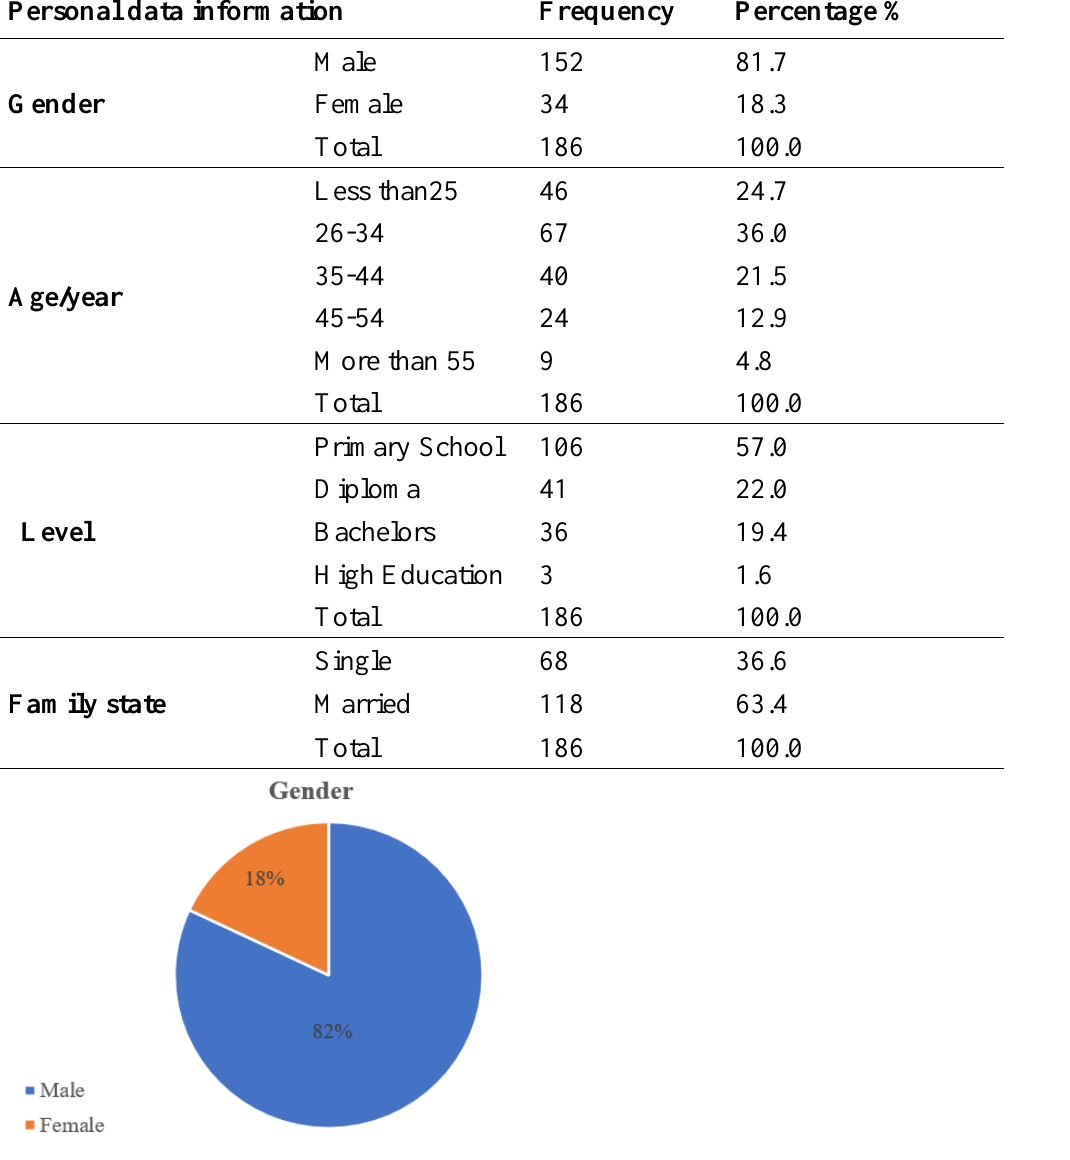
Figure 1. Percentage of